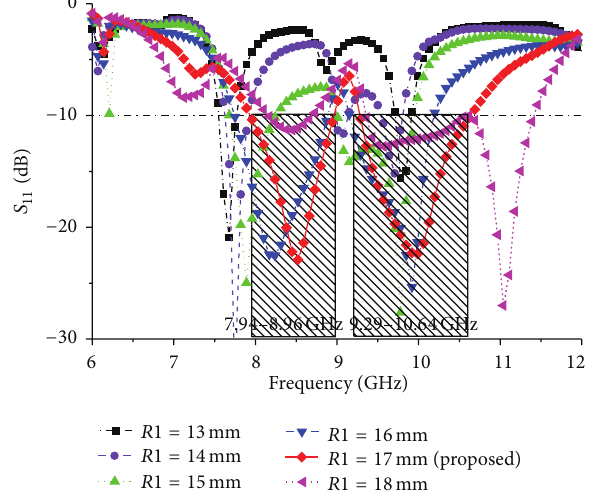
Figure 9: Simulated return loss for the different values of ground plane elliptical slot radius 𝑅1